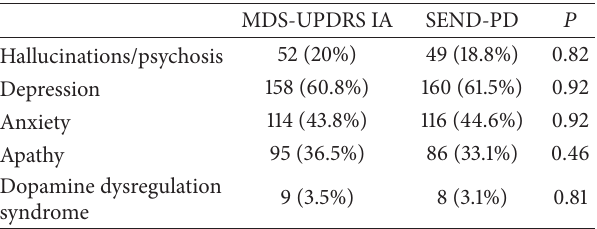
Table 1: Frequency ∗ of neuropsychiatric symptoms assessed by the MDS-UPDRS part IA and